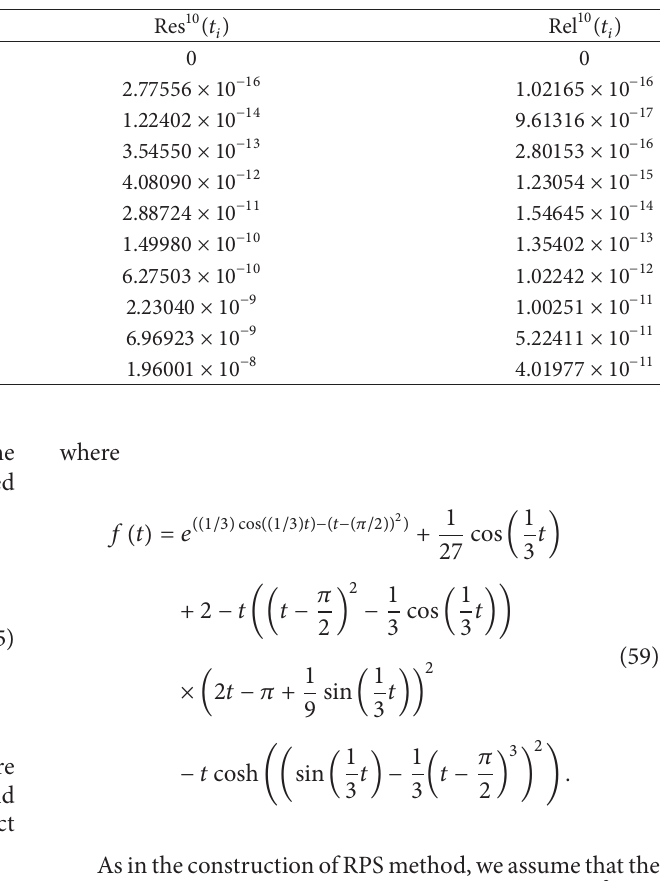
Table 2: The values of different error functions at 𝑘 = 10 for different values of 𝑡